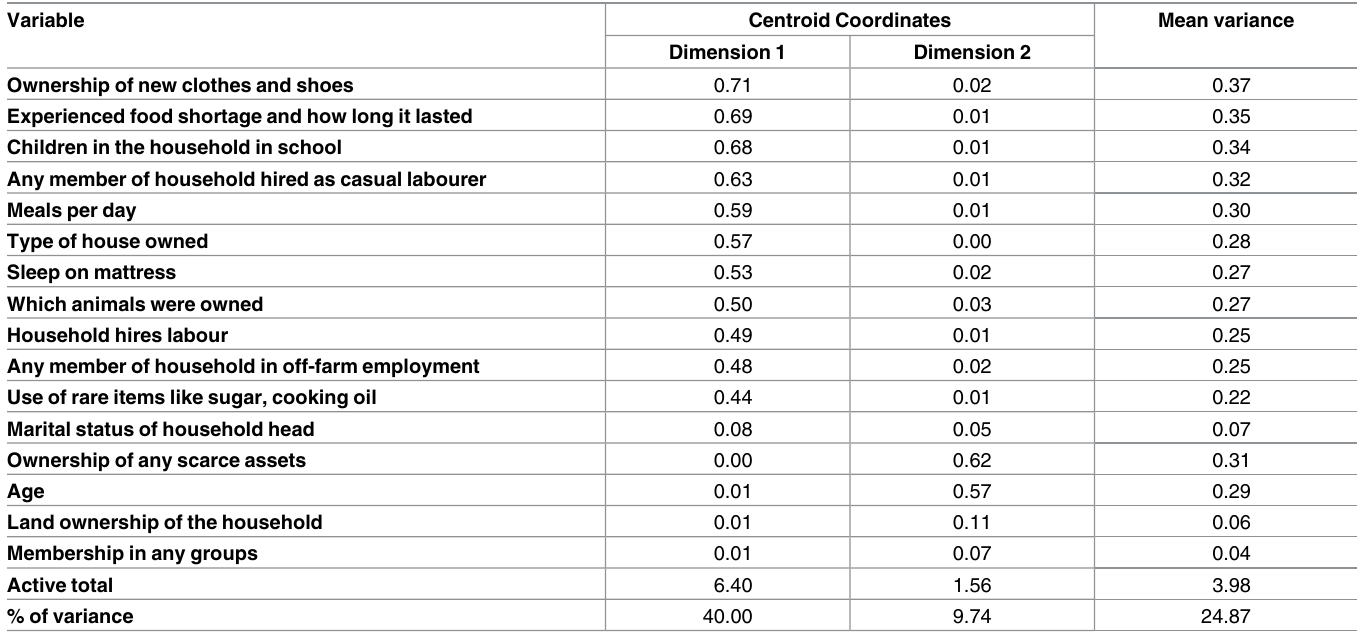
Table 3. Factor loadings for well-being indicators based on varimaxrotation.